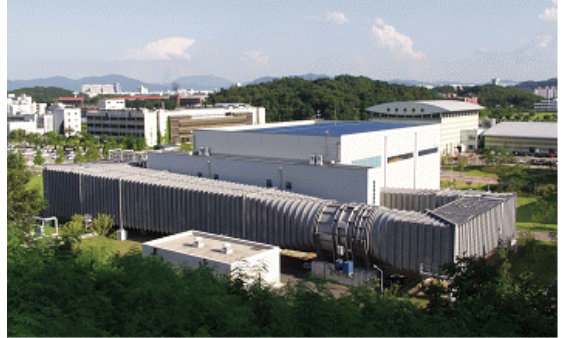
Figure 1 KARI Low-speed Wind